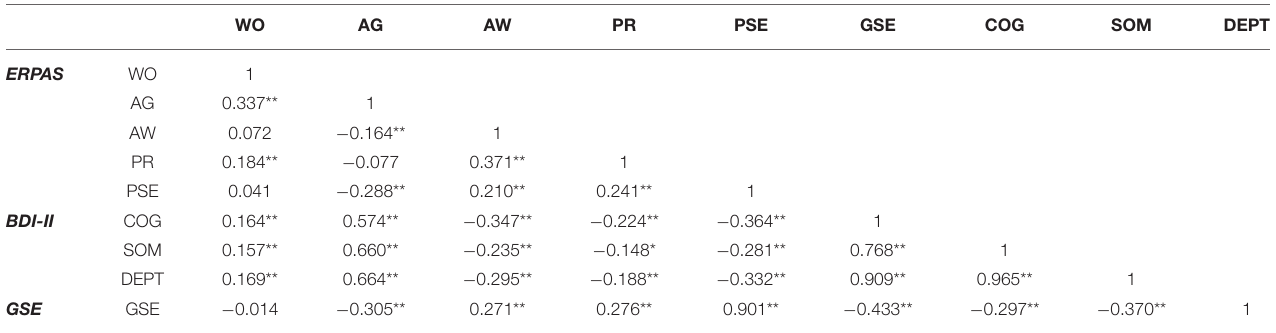
TABLE 6 | Correlations of the Emergency Response and Psychological Adjustment Scale (ERPAS) with the Generalized Self-Efficacy Scale (GSES) and the Beck Depression Inventory-II (BDI-II). WO AG AW PR PSE GSE COG SOM DEPT ERPAS